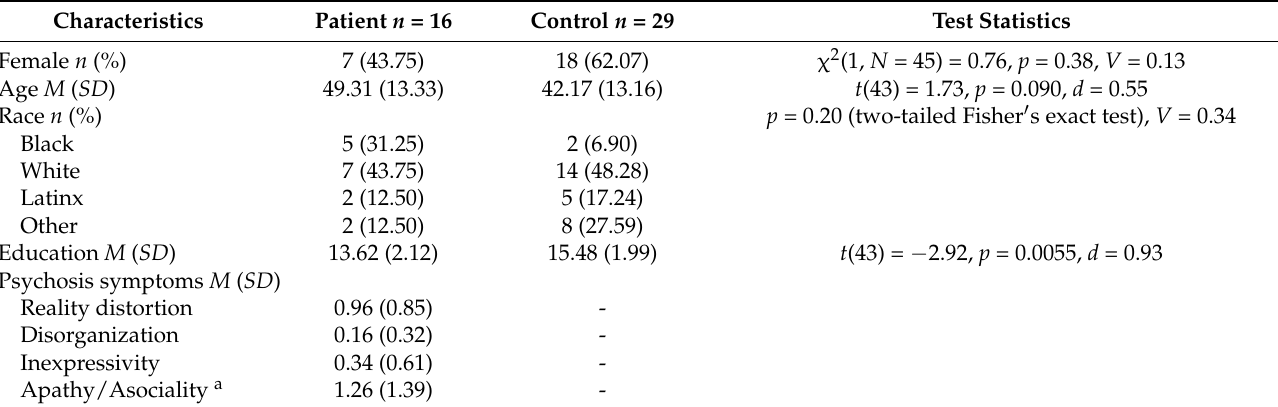
Table 1. Demographic and clinical characteristics of